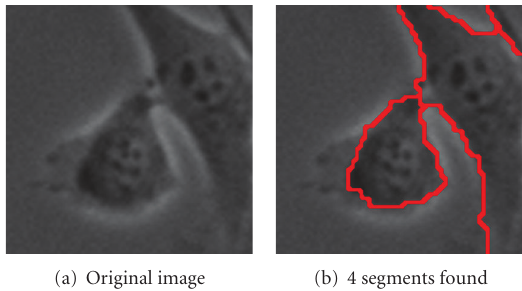
Figure 9: Parameters used: (b) n = 60, α = 130, (cid:7) α = 4, β = 100, θ = 0 . 1, γ = 0 . 8, d 1 = 0 . 15, σ = 6, ρ =